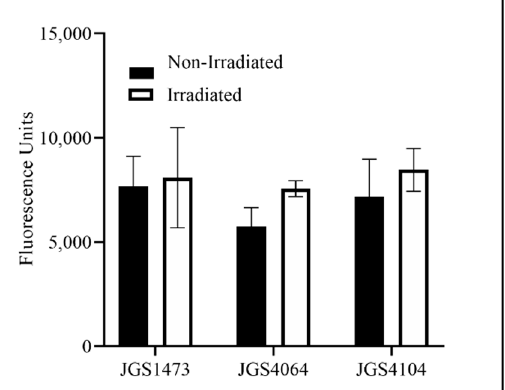
Figure 2. Fluorescence recorded for eBeam-killed and non-irradiated (live cells) of three strains of Clostridium perfringens (JGS4064, JGS1473, and JGS 4104) stained with alamarBlue TM to determine the metabolic activity. Dark bar—non-irradiated CP cells; white bar—eBeam-killed CP cells (irra- diated).